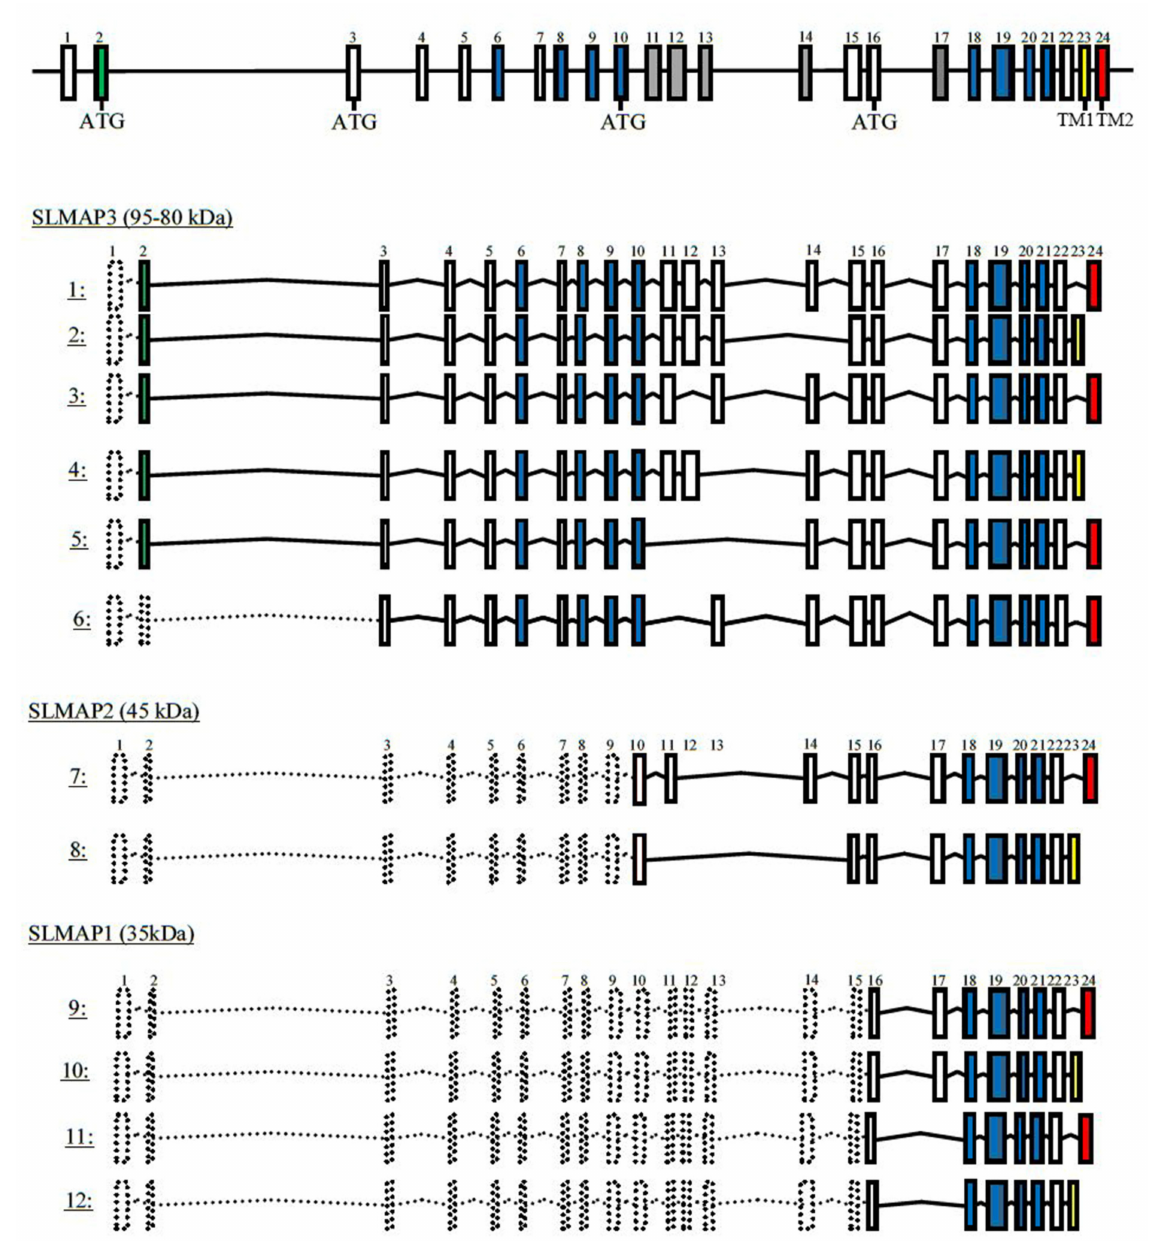
Figure 2. Intron-exon junction of mouse SLMAP gene and its splice variants. SLMAP consists of 24 exons (black) and alternatively splices to generate numerous isoforms grouped as three isoforms, SLMAP1 (35 kDa), SLMAP2 (45 kDa) and SLMAP3 (80–95 kDa). The start codon (ATG) for SLMAP3, SLMAP2 and SLMAP1 are found at exon 2/3, 10 or 16, respectively. Alternative splicing of exons 11, 12, 13, 14 and 17 results in each isoform presenting unique variants. Exon 2 (green) codes for the FHA domain. Exons 6, 8, 9, 10, 18, 19, 20 and 21 (blue) code for the coiled-coil LZ domains. Mutually exclusive exons 23 (yellow) and 24 (red) code for transmembrane domain 1 (TM1) or transmembrane domain 2